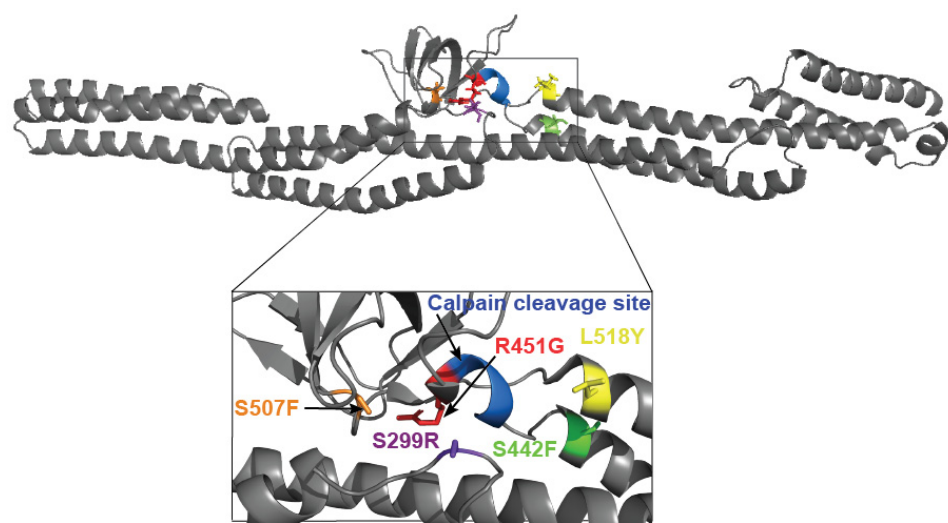
Figure 1. Cartoon representation of Desmoplakin structure. Ribbon model of DSP (178–627; PDB# 3R6N) showing the location of the affected calpain target site (blue) and mutated residues. Red (R451G) and purple (S299R) are proximal variants to the calpain target site, while orange (S507F) and green (S442F) are denoted as distal variants.